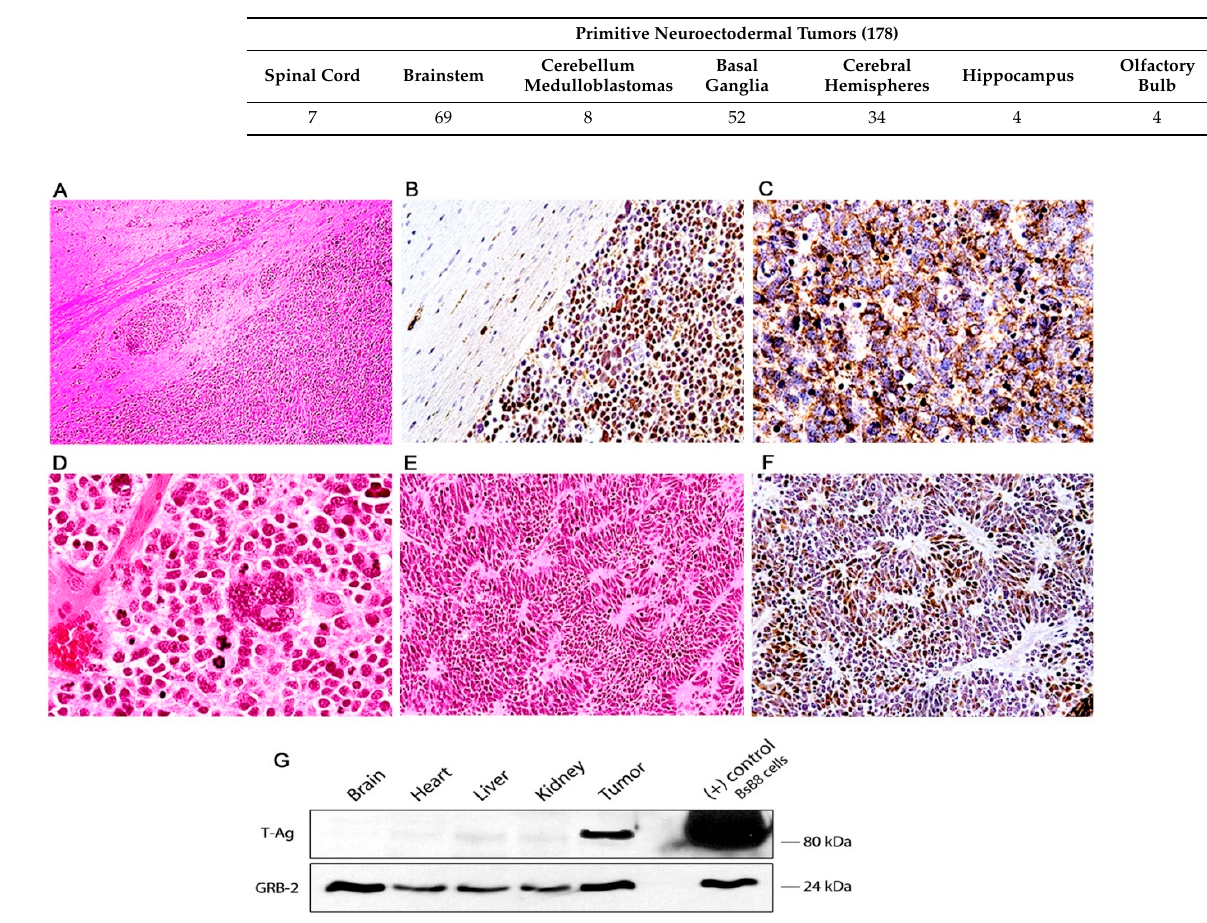
Table 2. Location of primitive neuroectodermal tumors developed in JCPyV (CY) transgenic mice. In 23 cases the tumors involved both the cerebral cortex and the basal ganglia. In 5 cases the tumors involved all parts of the forebrain. 19 cases demonstrated subarachnoid dissemination. Tumors with this phenotype originating in the cerebellum were classified as medulloblastomas.